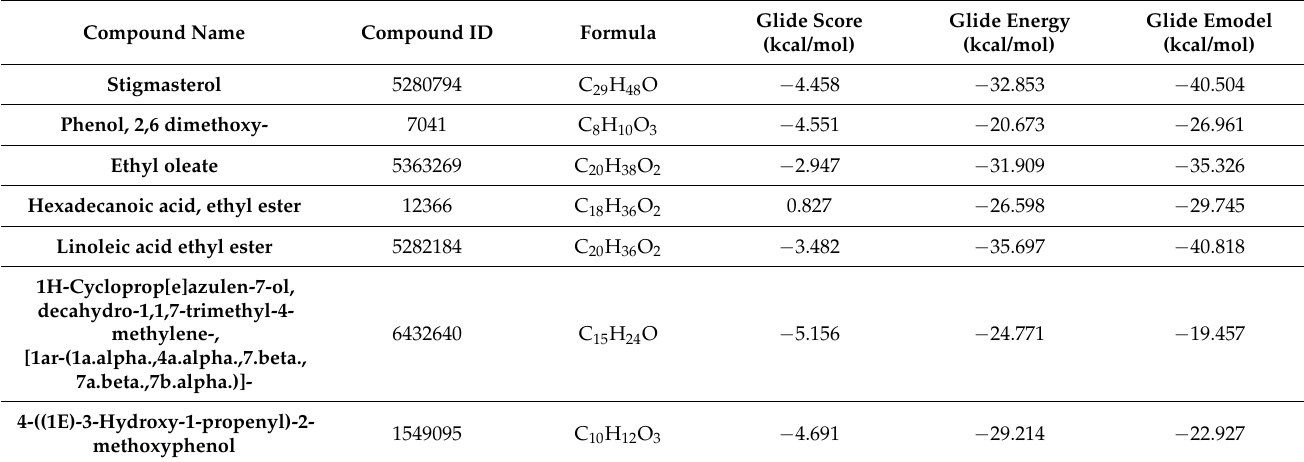
Table 4. Docking results with ligands in the caspase-3 (PDB:3GJQ)